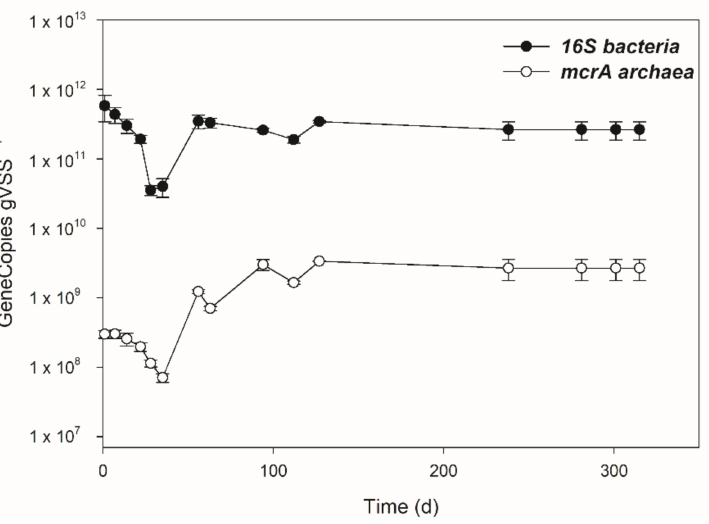
Figure 4. Abundance of methanogens (mcrA gene) and bacteria (16S rRNA gene) estimated by qPCR at different sampling times. Data expressed as gene copies per gram of volatile suspended solid